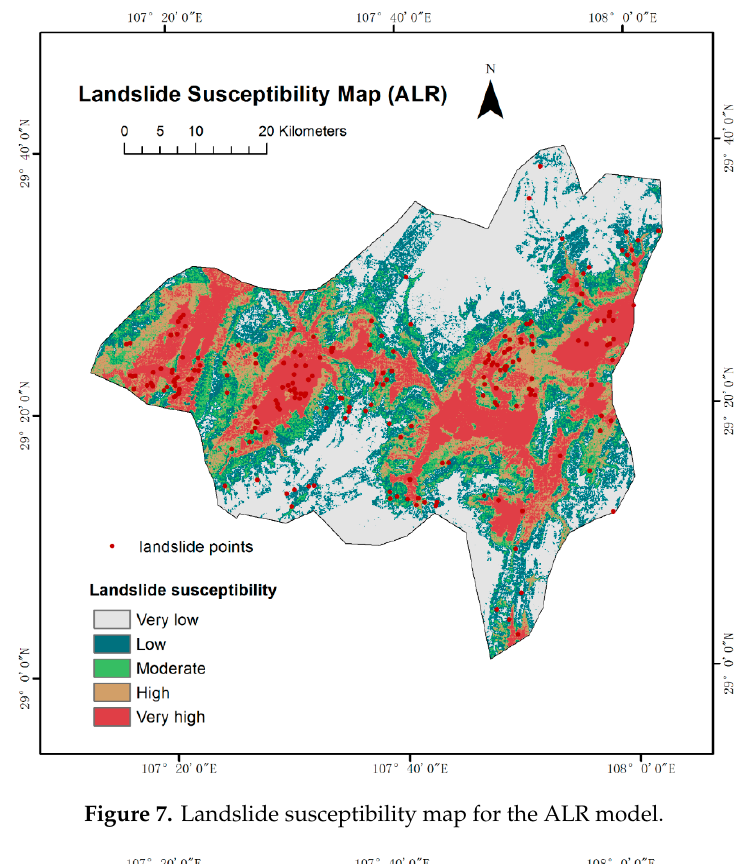
Figure 6. Landslide susceptibility map for the LR model.